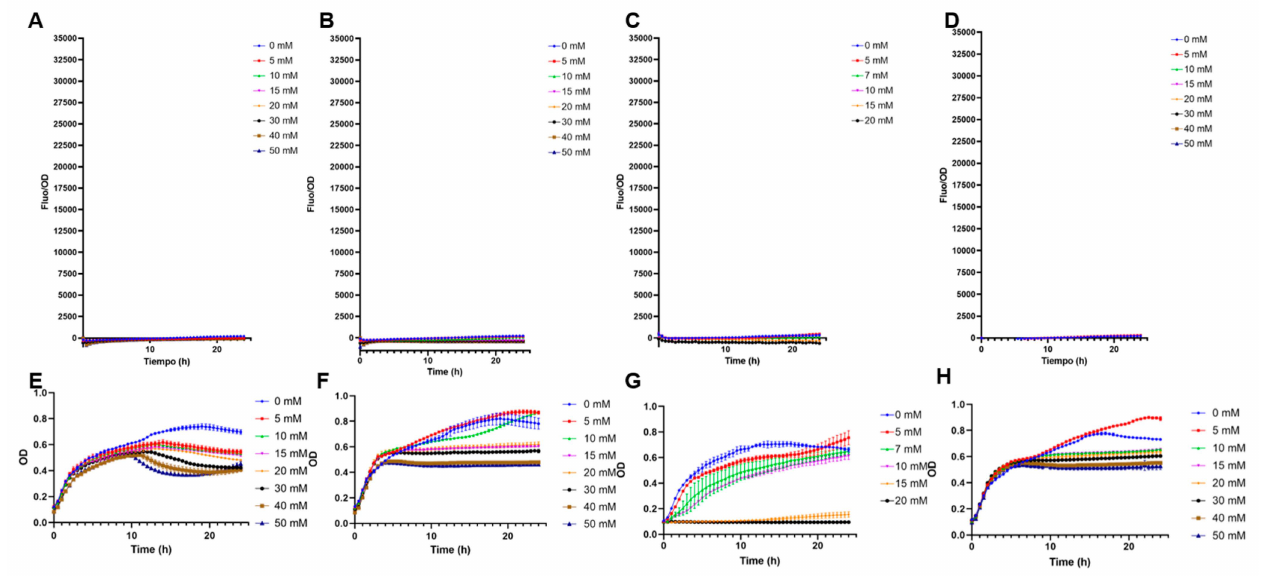
Figure 3. Specificity tests of E. coli BL21 containing pFuc_FucR_colE1, using sfGFP as a reporter. ( A ) F/OD values in the presence of increasing concentrations of galactose; ( B ) glucose; ( C ) sialic acid; ( D ) mannose; ( E ) growth curves (OD values) of this strain in the presence of increasing concentrations of galactose; ( F ) glucose; ( G ) sialic acid; ( H ) mannose. Kinetics and growth curves were performed in triplicates and are presented as average ±